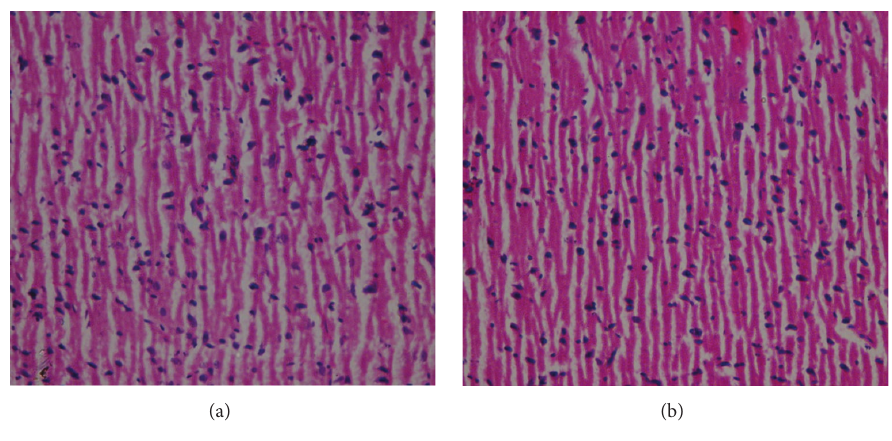
Figure 3: (a) Treated brain. (b) Control